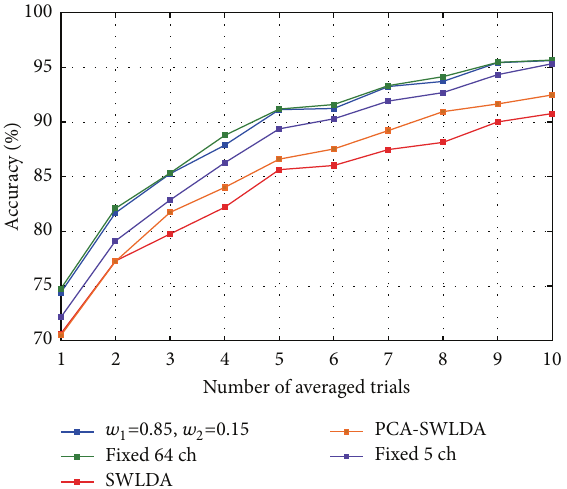
Figure8:Averageclassificationaccuracyacross12subjectsachieved by the Fixed 5 case (purple line). Other colors show the accu- racy obtained by the Fixed 64, SWLDA, PCA-SWLDA, and the MHPSO(4)